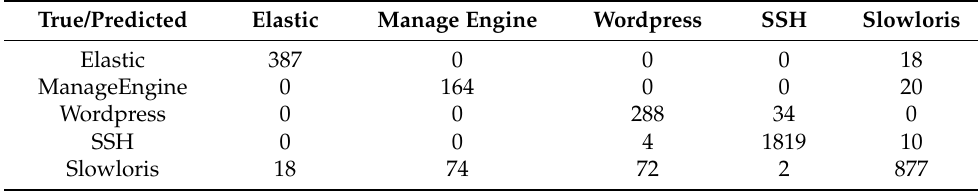
Table 3. Confusion matrix for enhanced